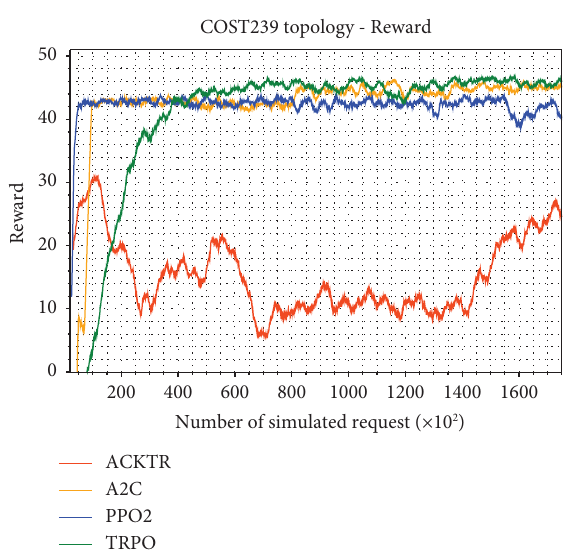
Figure 4: Accumulated reward for the A2C, PPO2, TRPO, and ACKTR agents in the COST239 topology.